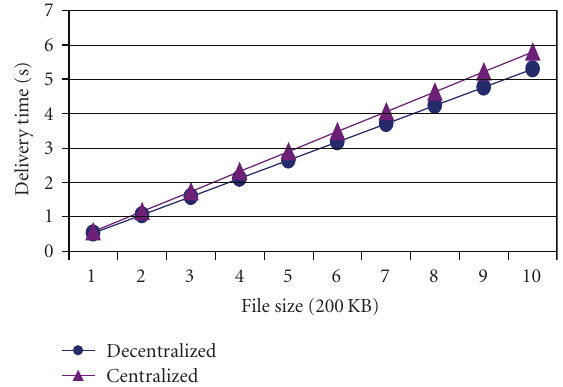
Figure 9: Data delivery time versus file size. (Bandwidth = 54Mbps, three services are considered.)